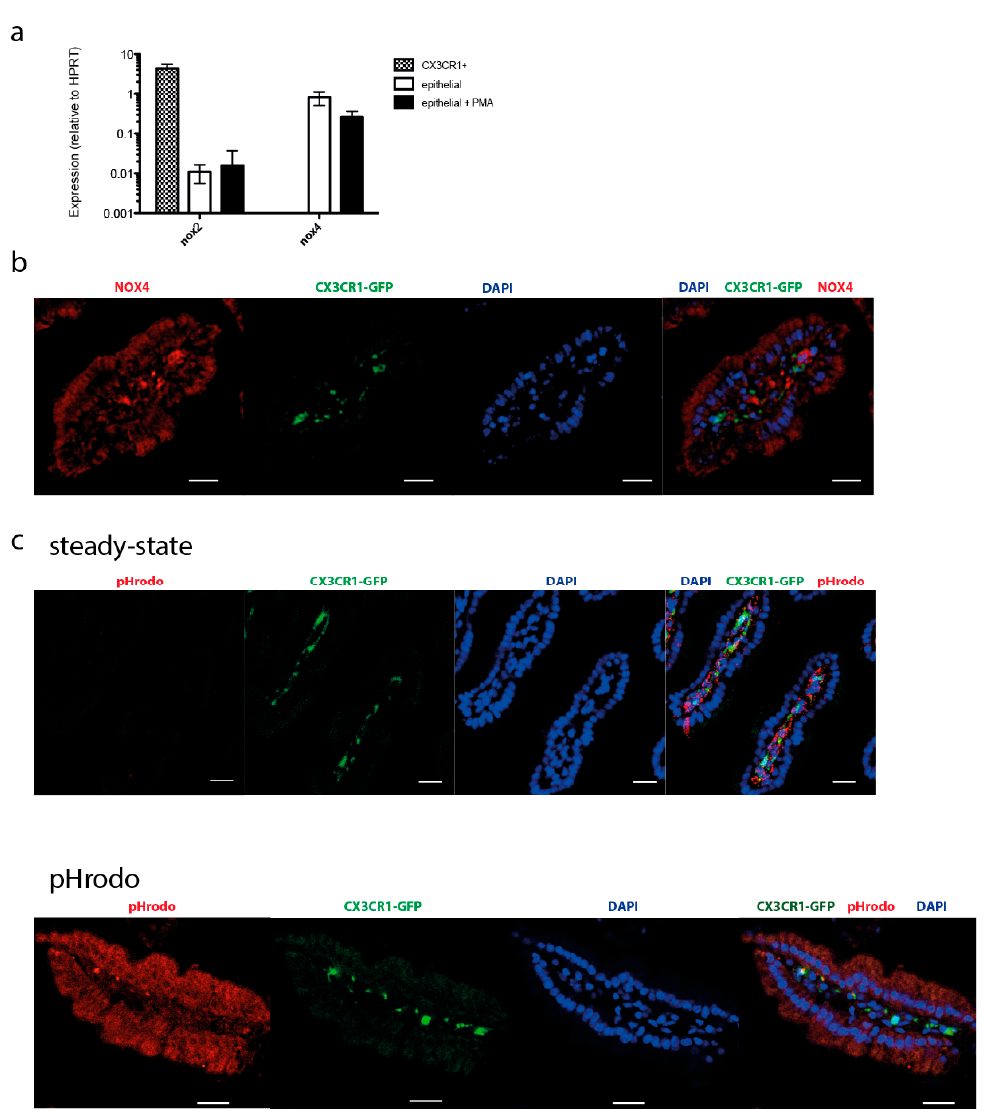
Figure 4. Expression of NOX isotypes in the epithelial and myeloid compartments of the small intestine. ( a ) RT-PCR. CX3CR1-GFP + and epithelial cells were sorted from the small intestine to examine their expression of NOX enzymes in the steady-state or after activation with PMA. Bar graph indicates the relative expression of Nox2 and Nox4 relative to HPRT. No significant difference was observed upon PMA treatment. Results shown are representative of three independent experiments; columns and error bars indicate mean +/ − SEM. ( b ) Immunofluorescence micrograph of the small intestine from a CX3CR1-GFP mouse, immunostained for Nox4. Nox4 is expressed at high levels in GFP + and GFP − cells in the LP, and at moderate levels in epithelial cells. Scale bar is 20 µ m. ( c ) Immunofluorescence micrograph of the small intestine before (top) and after (bottom) incubation with pHrodo bioparticles. At physiologic pH the pHrodo beads are non-fluorescent. pHrodo accumulation is seen as bright clusters in GFP + and GFP − cells in the LP, and diffusely throughout the epithelium. In the steady-state, no pHrodo signal is observed. pHrodo bioparticles are rapidly taken up and found in acidic compartments of GFP + and GFP − cells. Immunofluorescence images are representative of three independent experiments; scale bar is 20 µm.